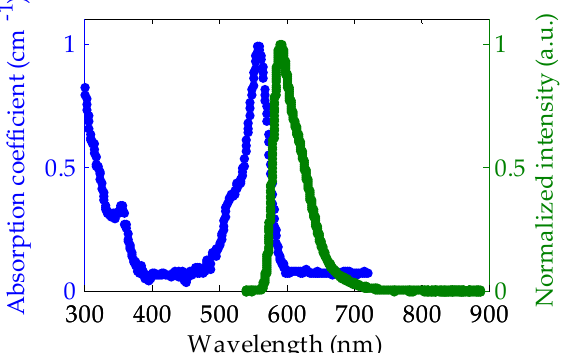
Figure 7. Absorption coefficient and emission spectrum corresponding to our POF doped with rhodamine B by using the solution-doping technique at 10 °C. The emission spectrum corresponds to an excitation wavelength of 520 nm and to a propagation distance of 4 cm.